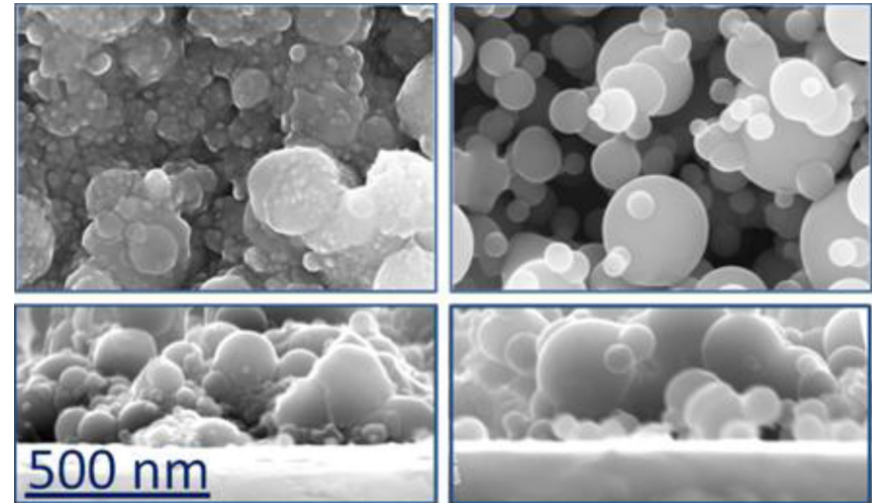
Figure 4. FESEM images representative of TiO 2 films. Left panel: films deposited at p < 1 mbar; right panel: films deposited at p > 1 mbar. Lower panels report cross section of the same films. Reprinted with permission from [71], copyright 2013 Elsevier.